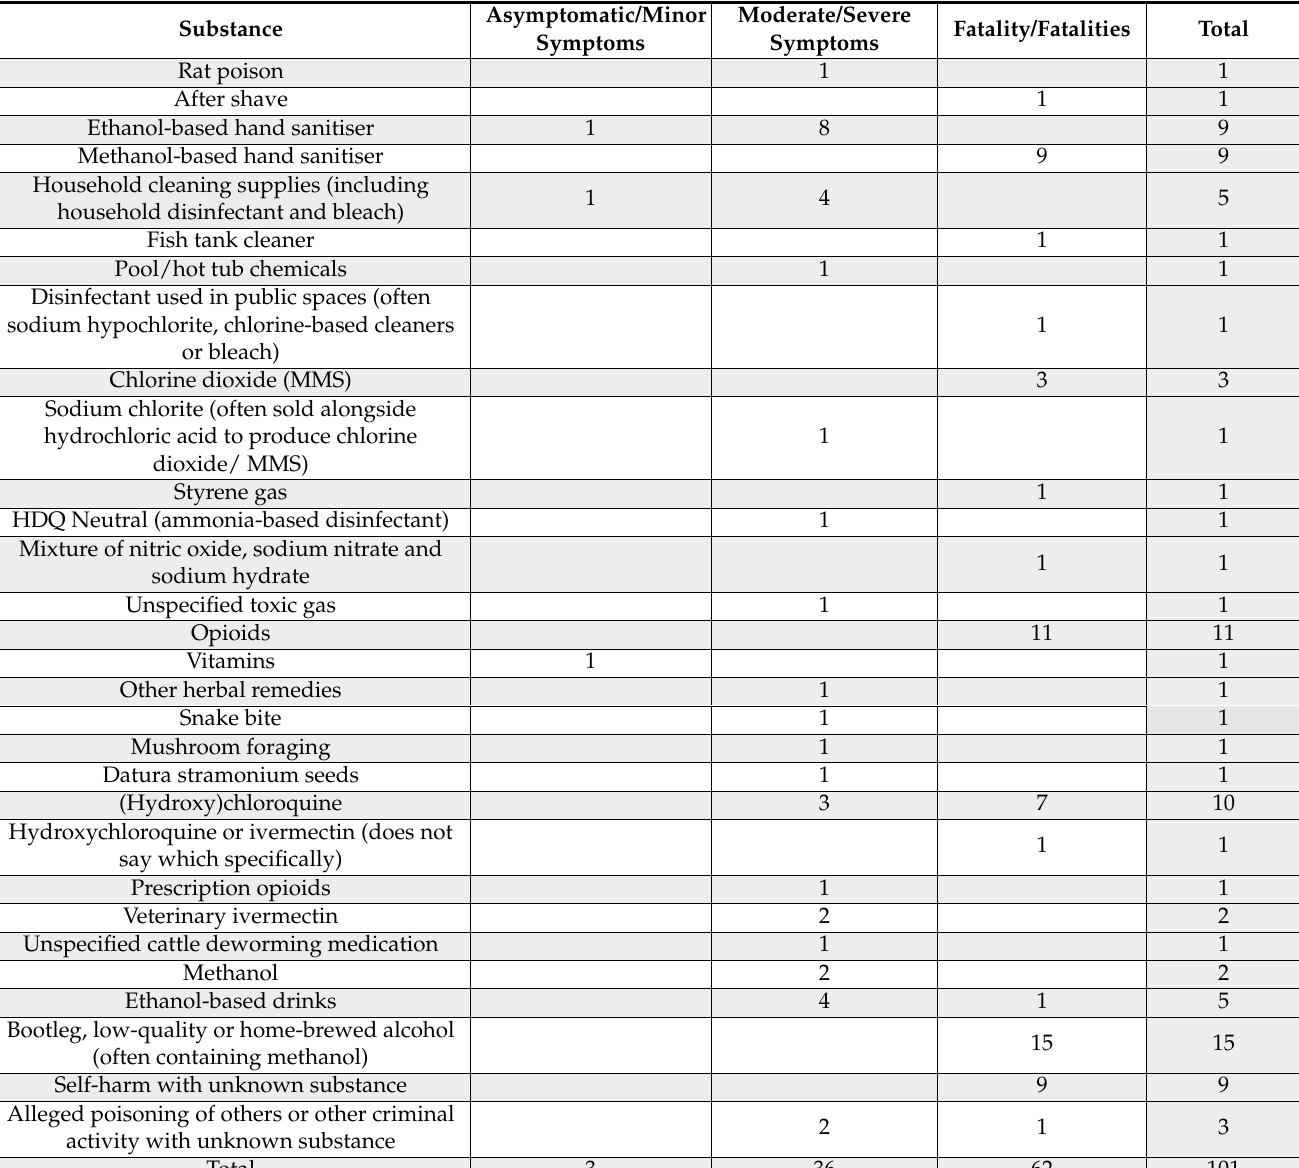
Table 4. Severity of actual poisonings in reports where case symptoms and/or severity are indicated ( n = 101). Asymptomatic/Minor Moderate/Severe Substance Fatality/Fatalities Total Symptoms Symptoms Rat poison 1 1 After shave 1 1 Ethanol-based hand sanitiser 1 8 9 Methanol-based hand